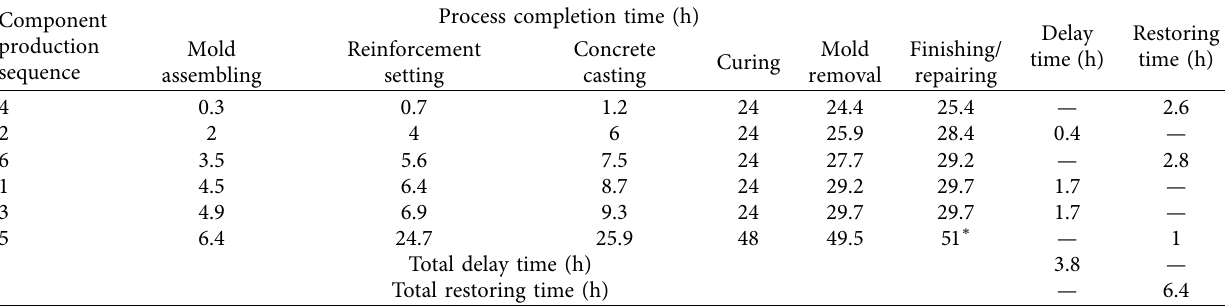
Table 2: Completion time of each process based on the FSSM.